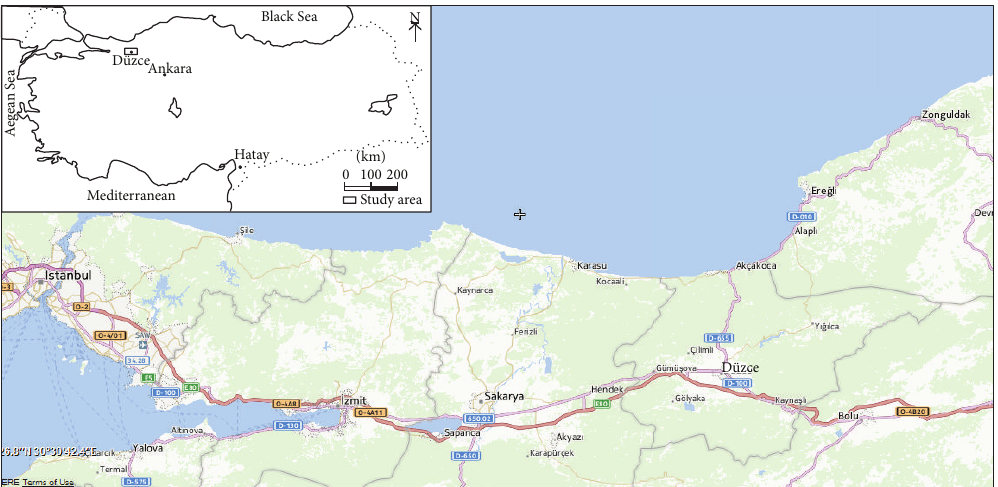
Figure 1: The study area (Duzce Province).